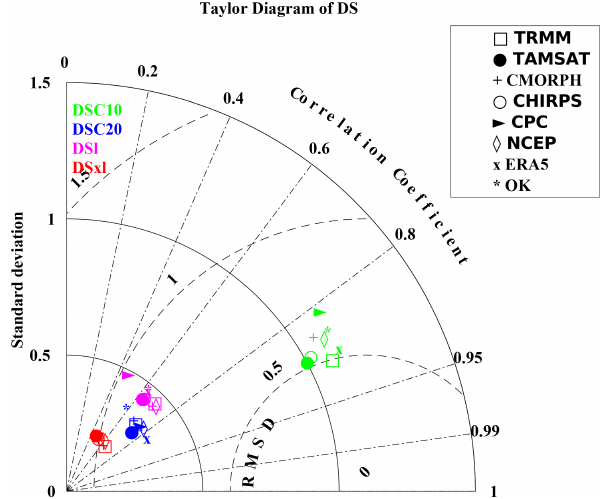
Figure 8. Taylor diagram providing three statistical scores (stan- dard deviation, correlation coefficient, and root mean square devi- ation), in which radius expresses the standard deviation, the angle expresses the correlation, and the distance from the bottom right point expresses the RMSD. The BK dataset is considered as a refer- ence for comparing the spatial distribution of the four categories of dry spells (DSC10, DSC20, DSl, and DSxl) of the different datasets (TRMM, TAMSAT, CMORPH, CHIRPS, CPC, NCEP, ERA5, and OK). BK is used as a reference. Details on the datasets and dry spells are provided in Tables 1 and 2,